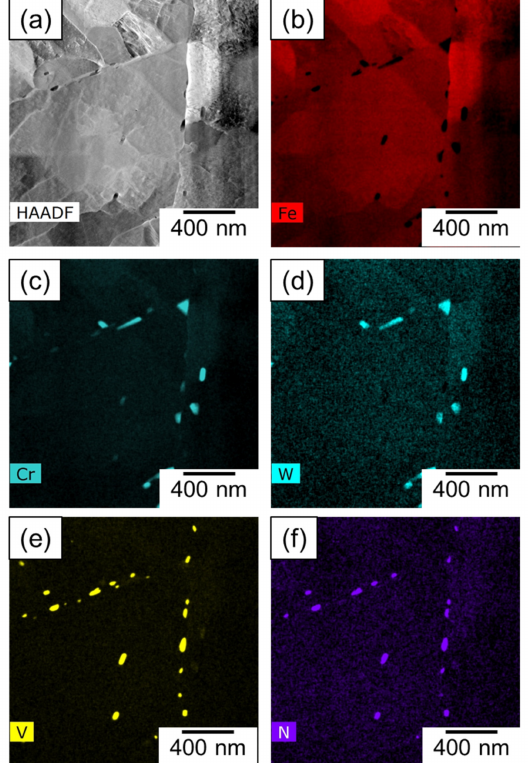
Figure 9. STEM EDS micrograph of the area displayed in ( a ) is showing that the structure is dominated by MX carbides after PPHT (HT-1). The elements Fe, Cr, W, V, and N are shown in ( b – f ) respectively.